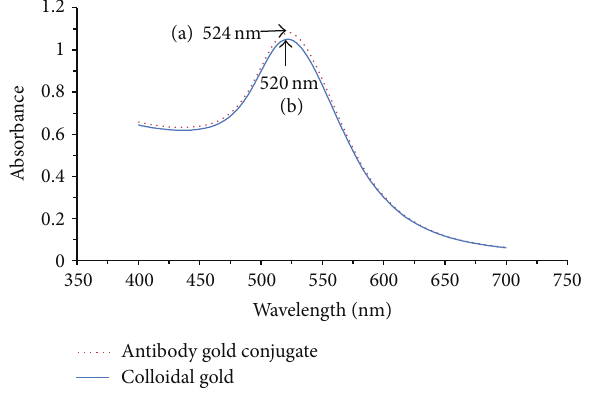
Figure 5: Visible spectra of the antibody gold conjugate and colloidal gold.